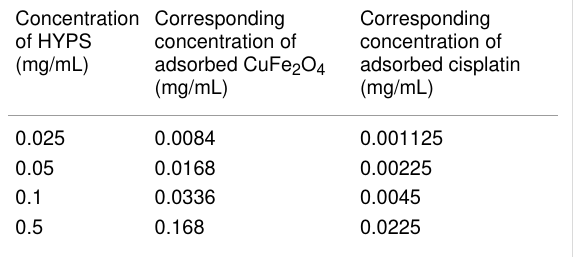
Table 1: Experimental concentrations for in vitro